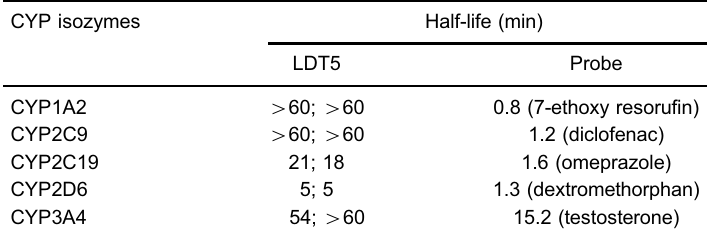
Table 2. In vitro results of various human CYP isozymes involvement in LDT5 metabolism. CYP